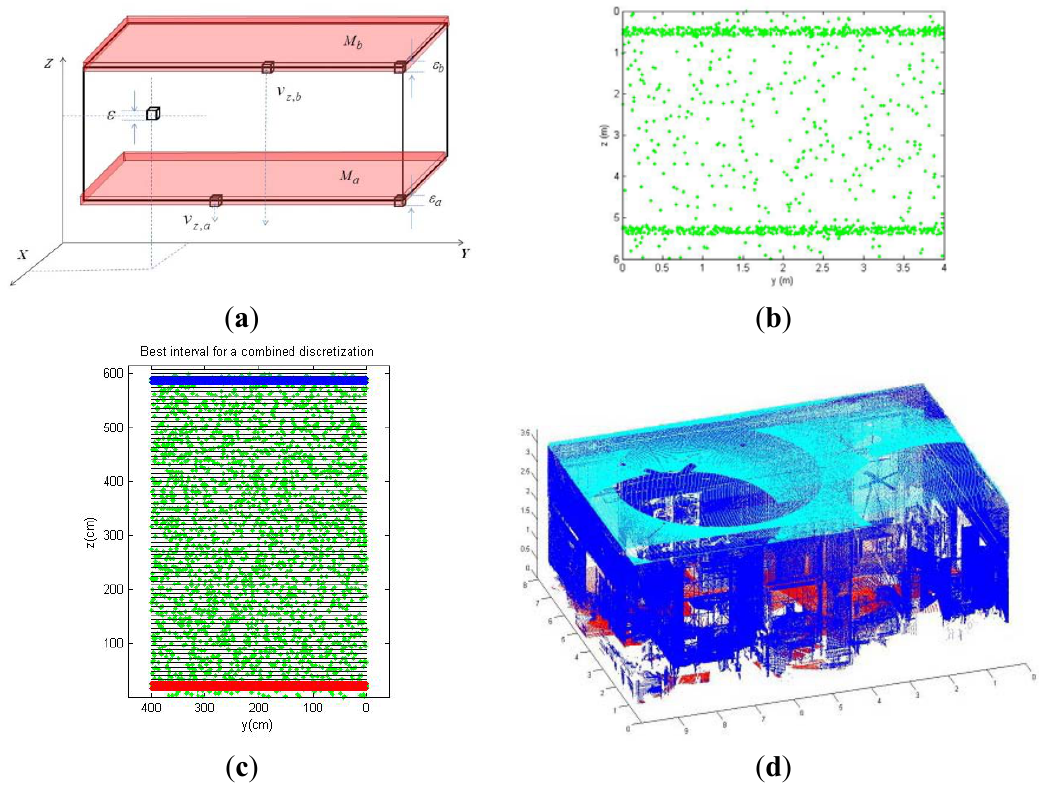
Figure 1. ( a ) Representation of the voxelized space. ( b ) and ( c ) Simulated data of the interior of a room and final discretization of the space. Blue and red planes of voxels containing the majority of the points of floor and ceiling. ( d ) Real segmentation. Point cloud sensed in a room and segmented points belonging to ceiling (cyan) and floor